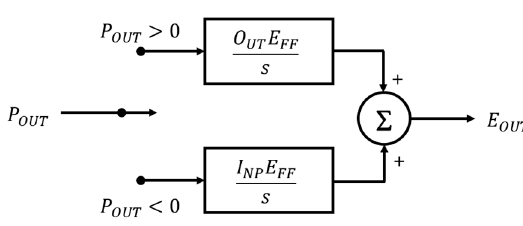
Figure 4. The reactive power control loop.